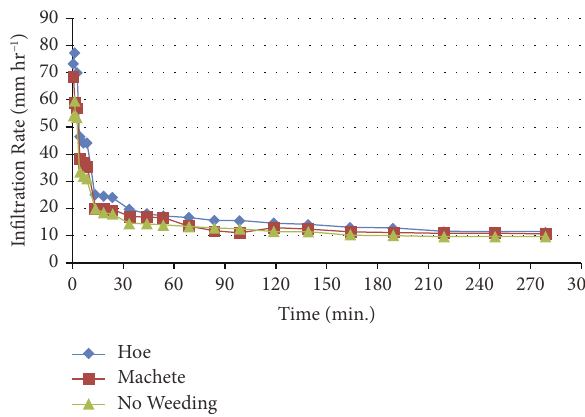
Figure 3: Effect of weed control methods on infiltration rate.